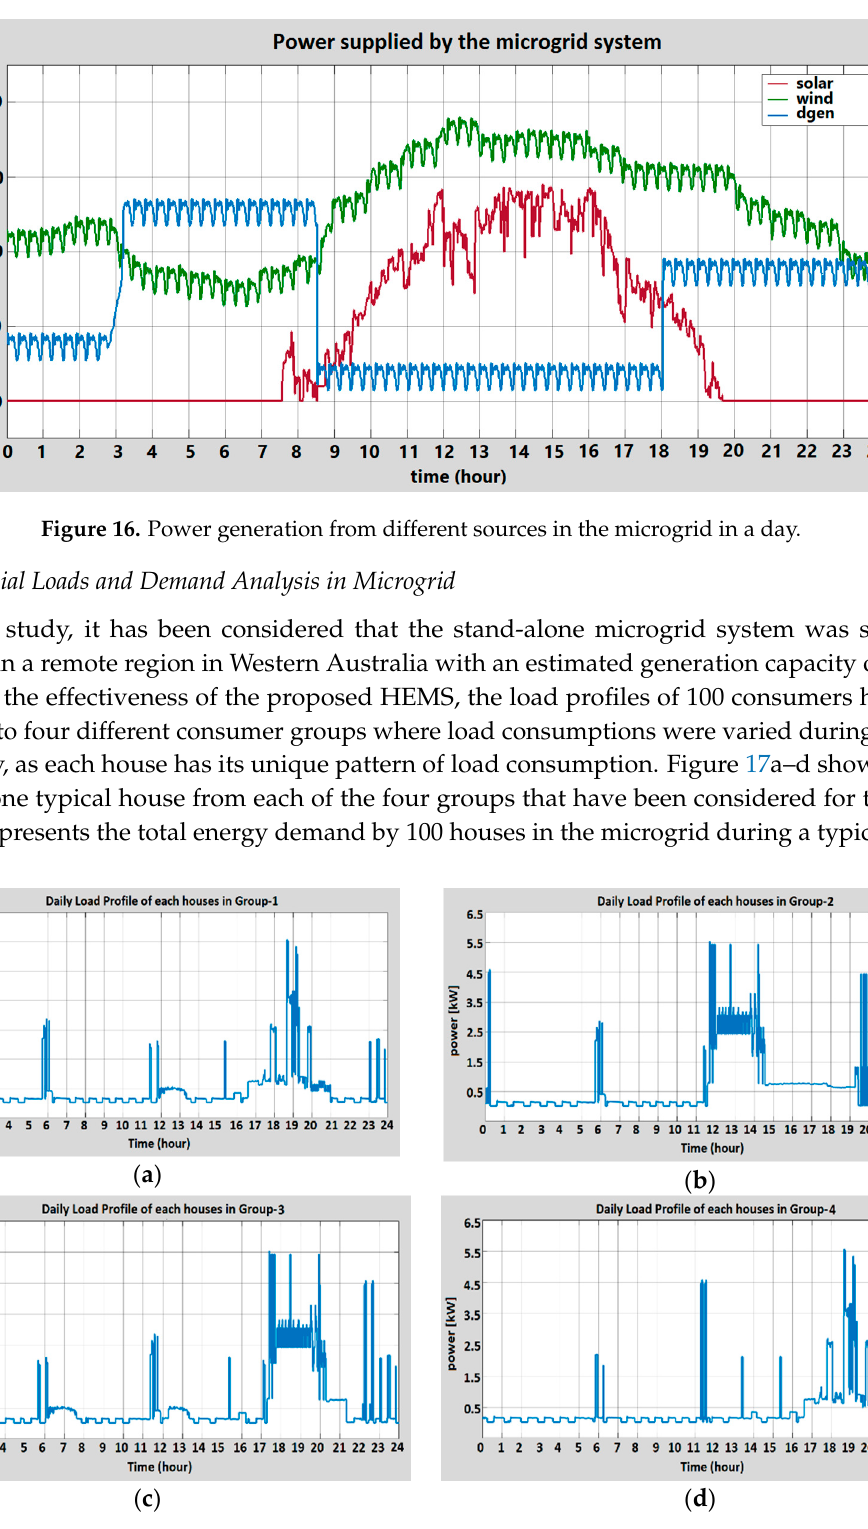
Figure 17. Daily load consumption pattern of each house in ( a ) Group-1; ( b ) Group-2; ( c ) Group-3; and ( d ) Group-4 on a typical day.